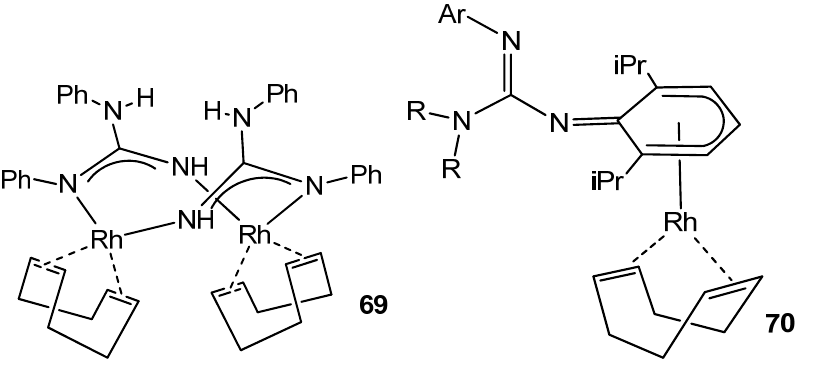
Figure 42. Bridging and arene coordination of guanidinato ligands in rhodium complexes.